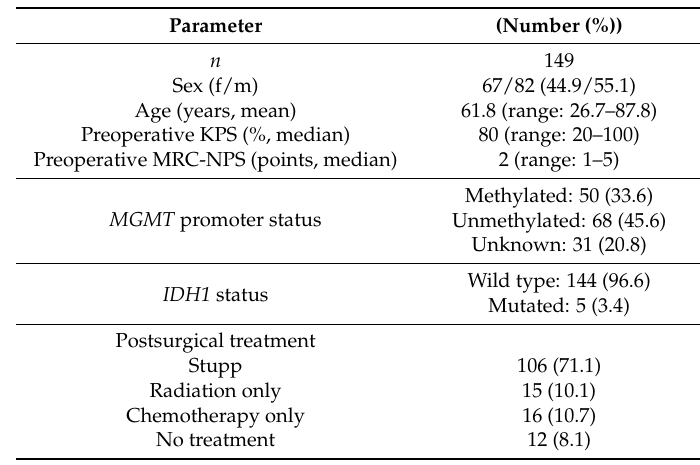
Table 1. Baseline characteristics of the entire study cohort. All patients were surgically treated for newly diagnosed